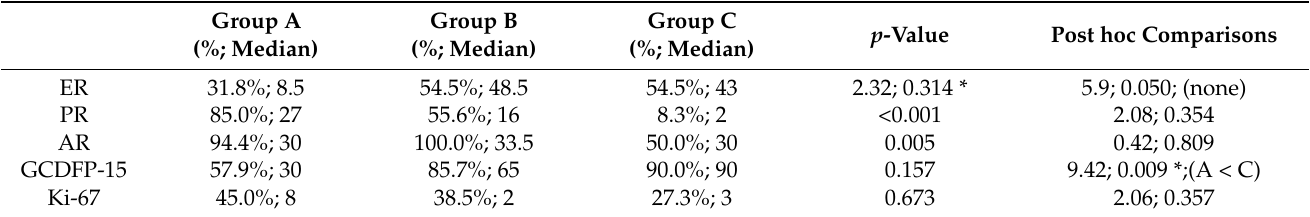
Table 3. Expression of hormone receptors according to age.